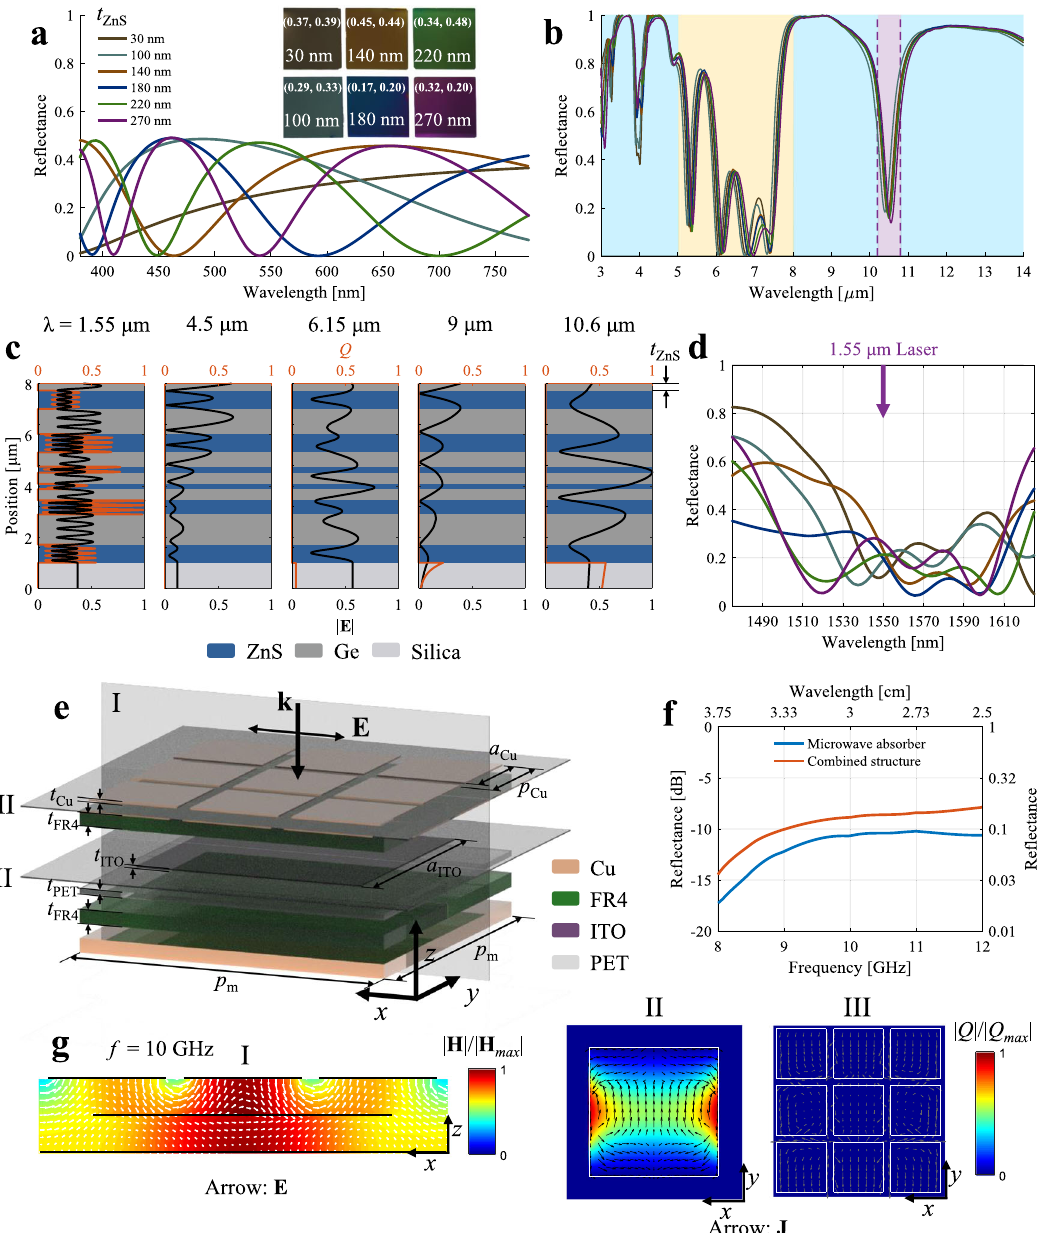
Fig. 2 Multispectral camou fl age for visible, MIR, lasers, and microwave. a The measured visible re fl ectance and optical images for top ZnS layer of thickness varying from 30 nm to 270 nm. The chromaticity coordinates ( x , y ) are written on the corresponding optical images (insets). b The measured re fl ectance in the MIR range for the different values of top ZnS layer thickness. c The electric fi eld | E | and resistive loss Q in the ZnS/Ge multilayer selective emitter for wavelengths of 1.55 μ m, 4.5 μ m, 6.15 μ m, 9 μ m, and 10.6 μ m. The thicknesses of the Ge/ZnS multilayer fi lms are 0.721/0.982/0.721/0.559/ 0.234/0.438/0.206/0.438/0.552/1.18/0.701 μ m (from top to bottom). d The re fl ectance spectrum near 1.55 μ m. e The Cu-ITO-Cu microwave absorptive metasurface. f The re fl ectance spectra corresponding to the Cu-ITO-Cu microwave absorber metasurface and the combined structure. g The normalized magnetic fi eld intensity (color) and electric fi eld (arrow) on the cross-section I ( x – z plane, parallel to polarization); the normalized resistive loss (color) and surface currents (arrow) on the cross-sections II and III, respectively ( x – y plane, perpendicular to wave vector). The frequency is 10 thickness compared to wavelength (Fig. 2b, see Section S3 for SE decay within the Ge/ZnS layers, forming high absorbance within re fl ectance spectra for different t ZnS ). Apart from the top ZnS the lossy silica substrate. layer, the thicknesses of the Ge/ZnS (gray/blue blocks) multilayer For lidar ’ s laser wavelength, the narrowband low re fl ectance at fi lms from top to bottom are optimized as shown in Fig. 2c. The 10.6 μ m wavelength is realized with the fi fth to seventh Ge/ZnS Ge/ZnS layers form a one-dimensional photonic crystal with layers (top to bottom, excluding the top ZnS layer), as shown by forbidden bands located at MWIR and LWIR ranges, as shown by the electric fi eld distribution at 10.6 μ m in the Fig. 2c. The the electric fi eld (| E |) and resistive heat loss ( Q ) distribution at forbidden band of the one-dimensional photonic crystal in LWIR 4.5 μ m and 9 μ m wavelengths (Fig. 2c). For the non-atmospheric is broken by these three layers, where high electric fi eld intensity window outside the forbidden bands, the electric fi eld does not is formed. For another lidar ’ s laser wavelength of 1.55 μ m, the